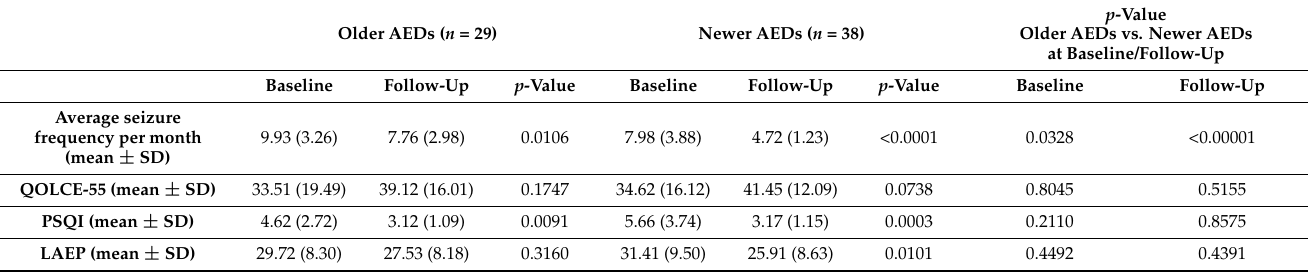
Table 2. Changes in the treatment efficacy parameters considered in the study ( n =